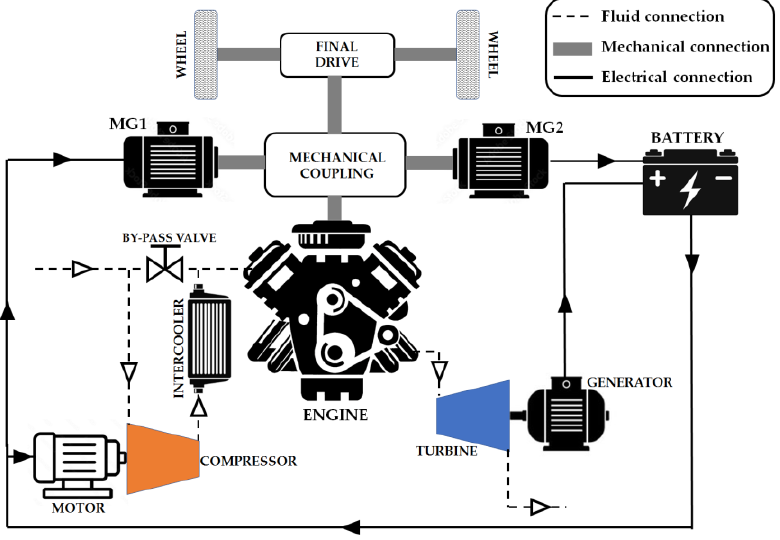
Figure 1. Schematic representation of the separated electric compound